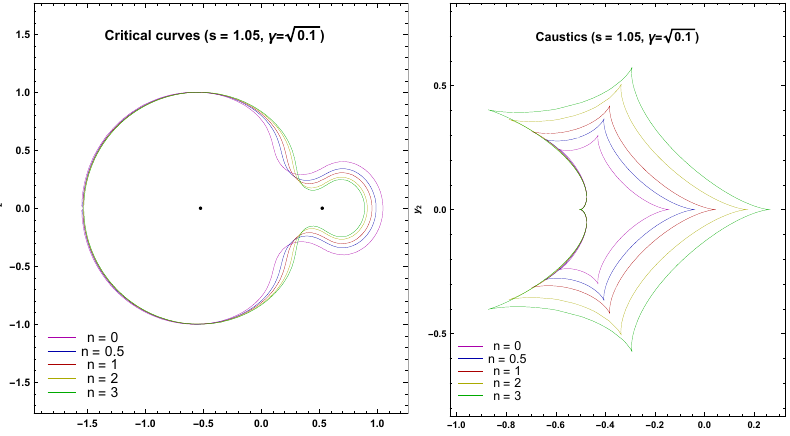
Figure 13. Critical curves and caustics in the unequal-strength binary with the standard lens on the right, intermediate-wide transition.